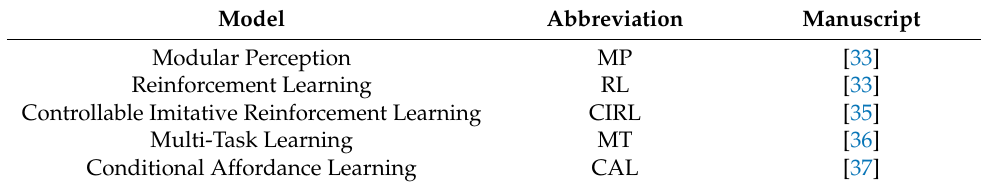
Table 2. Result Reproduction